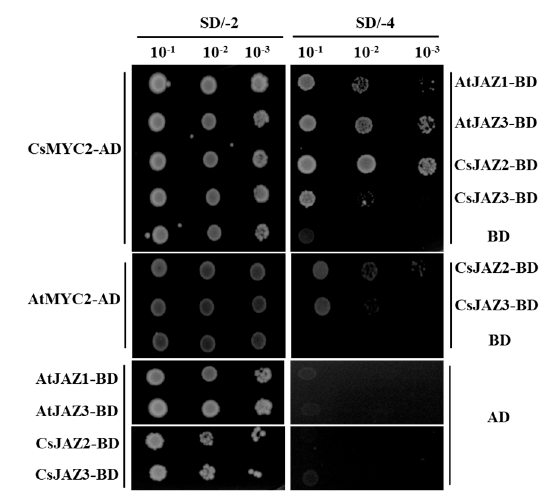
Figure 9. CsJAZs interacted with CsMYC2 and AtMYC2 in yeast two-hybrid assay. The AtJAZ1-BD and AtJAZ3-BD were used as positive control, while empty vector pGBKT7 plus CsMYC2-AD/ AtMYC2-ADand pGADT7 plus CsJAZ-BD/ AtJAZ-BD were set as negative control. The yeast cells were grown on SD/-Trp-Leu and SD/-Trp-Leu-His-Ade media with three concentration gradients.